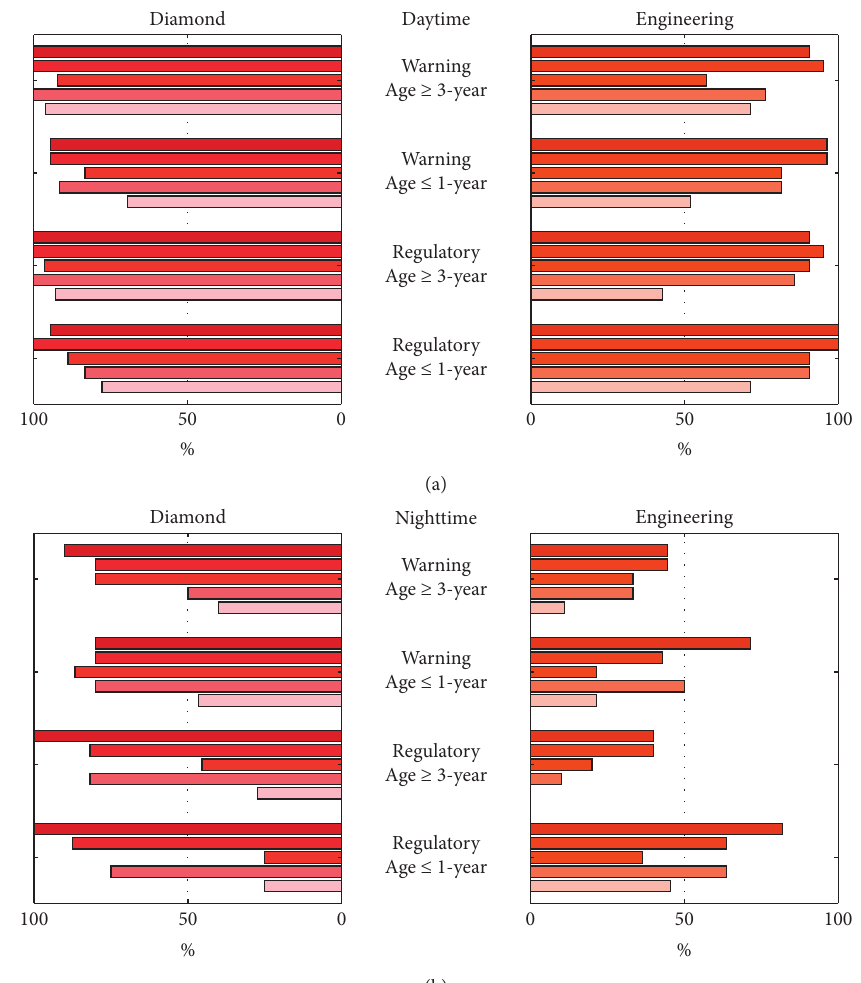
Figure 8: Recall parameter comparison between (a) sheeting types in daytime lighting and (b) sheeting types in night time lighting with different age